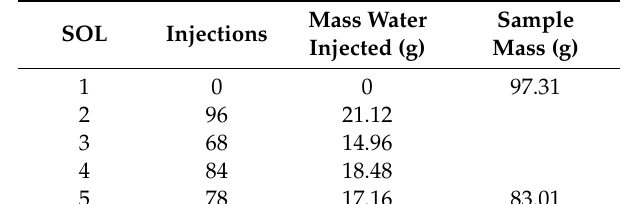
Table 4. Summary of the injection process in the Z sample.